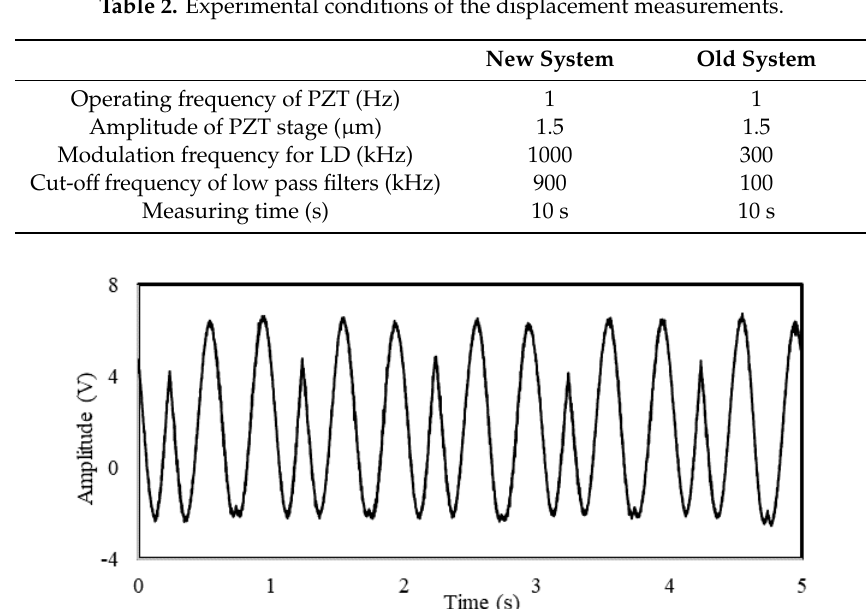
Table 2. Experimental conditions of the displacement measurements.